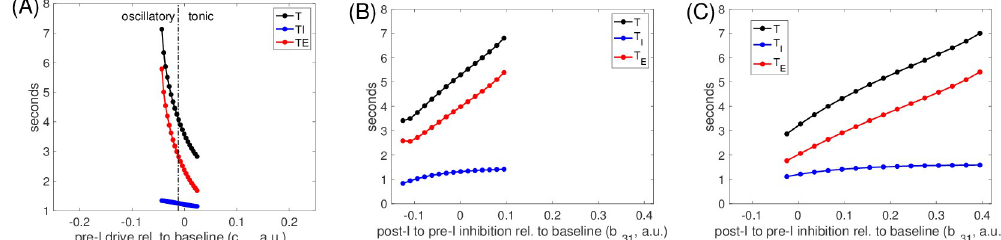
Fig 8. Input to the preBo¨tC pre-I node controls period by modulating T E . (A): Period (black), inspiratory duration (blue), and expiratory duration (red) versus drive to pre-I, c 11 , over the range of c 11 for which network rhythms were maintained. Values of c 11 where the pre-I unit is intrinsically oscillatory or tonic are separated (dash-dotted black line) and labeled. (B-C): Same curves versus the value of inhibition from post-I to pre-I, b 31 , relative to its baseline value (0.125; here labeled as 0) over the range where network rhythmicity is maintained; results are shown when the pre-I is intrinsically oscillatory (B), with c 11 = − 0.03, and tonic (C), with c 11 = 0.01. Increasing b 31 prolongs the time until pre-I activity can rise, leading to longer expiratory phase durations and